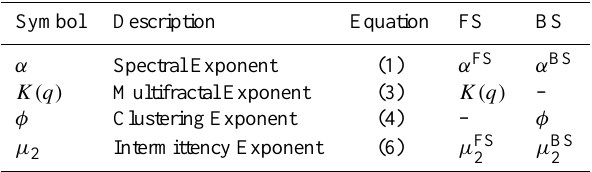
Table 1. Summary of the metrics used to investigate rainfall inter- mittency, including symbol, description, reference to the equation of the corresponding scaling law, and symbols adopted in the appli- cation to the full and/or the binary series (FS and BS,